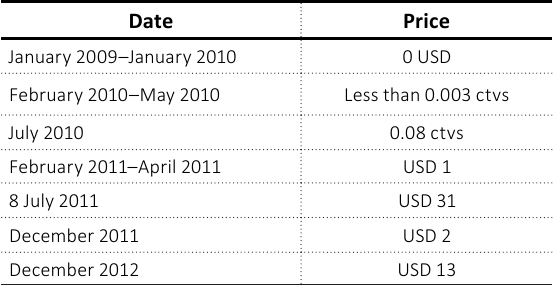
Table 1. Price of Bitcoin in 2009–2018